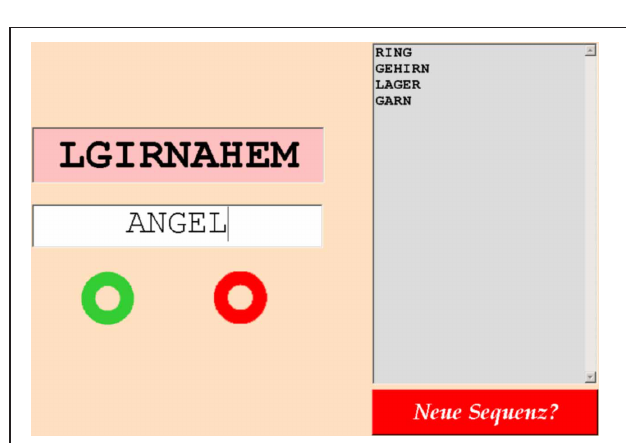
FIGURE 3 | Screenshot of the Word Puzzle task (Czienskowski, 2005b). German singular noun word solutions to a letter sequence (here, LGIRNAHEM) are typed into the entry field (here, ANGEL). Subjects receive feedback on if their solution is correct (green circle lights up) or incorrect (red circle lights up). All valid solutions that have been generated so far appear on the word stack (right side). Subjects can choose to move to the next letter sequence at any time by hitting the red switch sequence button (lower right). Hitting the switching button will initiate a waiting period in which a bouncing ball animation is shown (i.e., the travel time between subsequent letter sequences) followed by the appearance of a fresh letter sequence (with the entry field cleared and the word stack